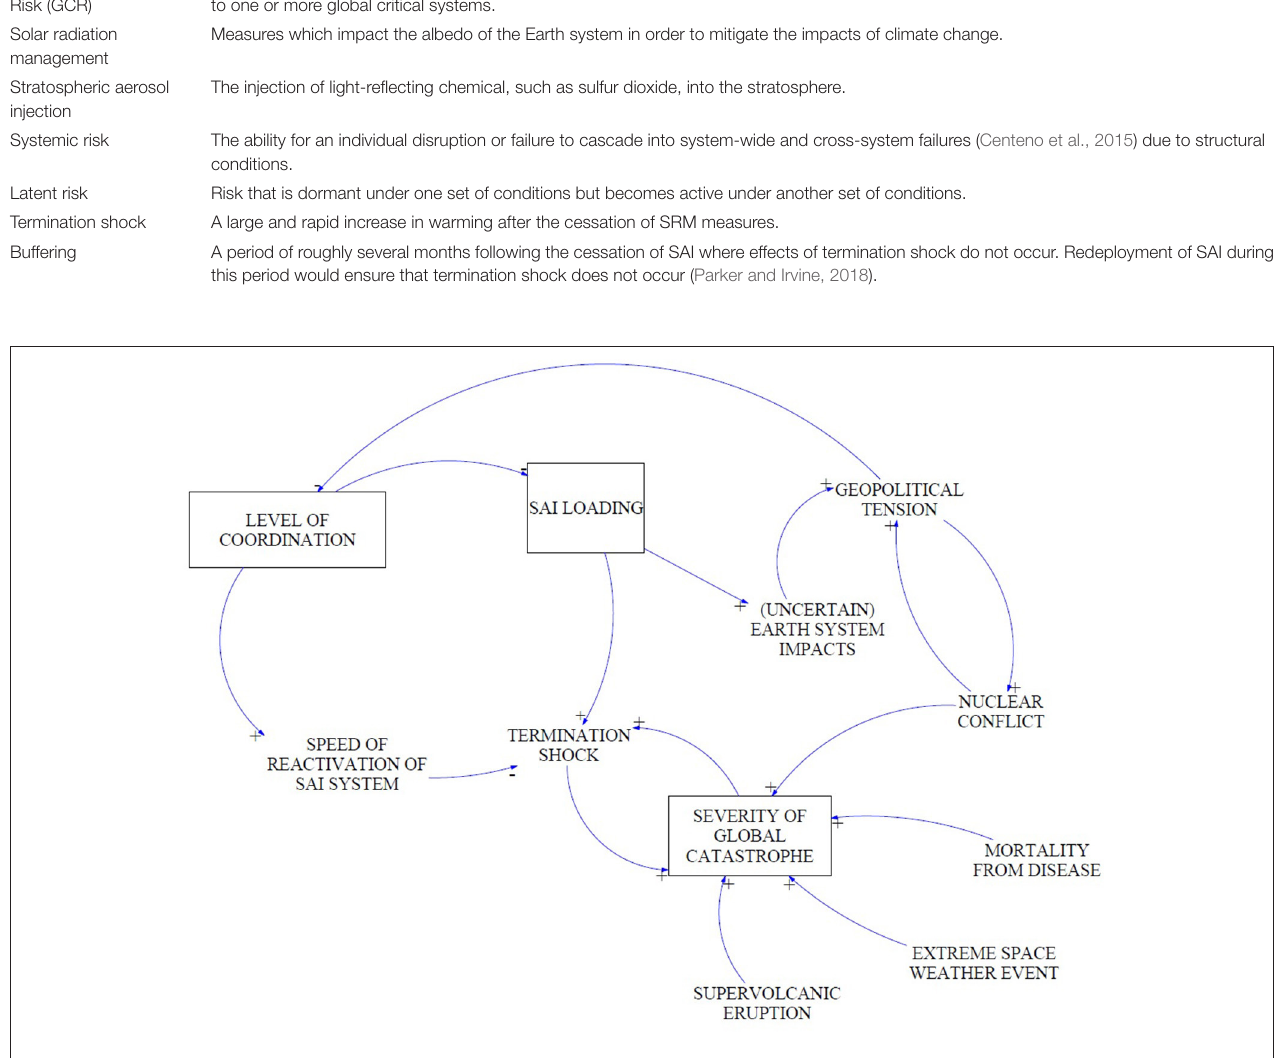
FIGURE 1 | The SAI-GCR system 2